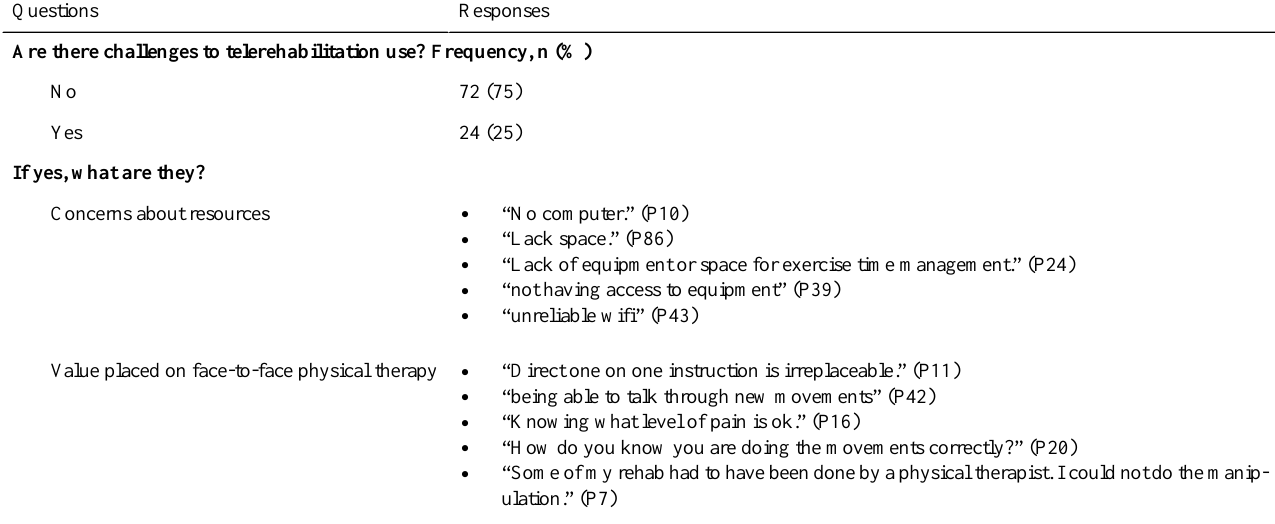
Table 3. Experiences and opinions on telerehabilitation: mixed data.